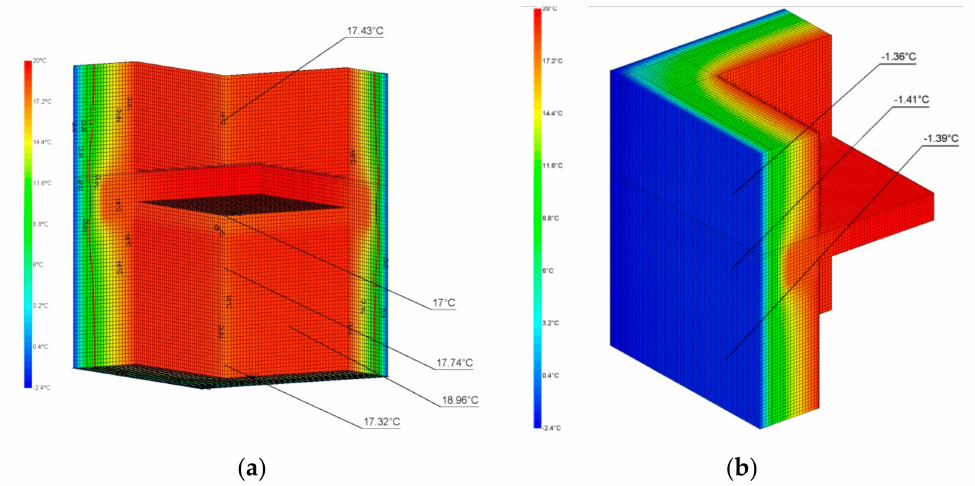
Figure 16. Distribution of isotherms in the model: ( a ) view from the side of the internal environment, ( b ) view from the side of the external environment Calculations carried out for microclimate conditions in accordance with ISO 13788 (i.e., t i = 20 ◦ C, t e = − 2.4 ◦